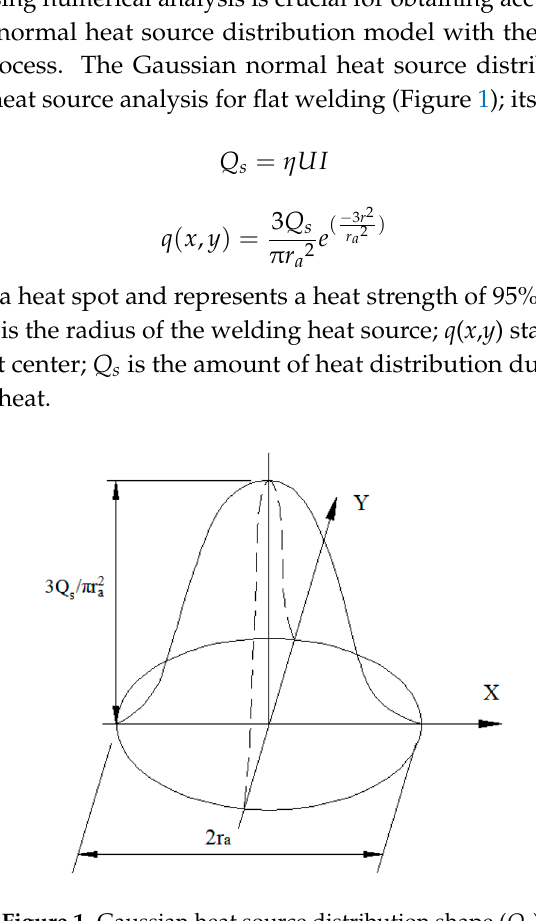
Figure 1. Gaussian heat source distribution shape ( Q s